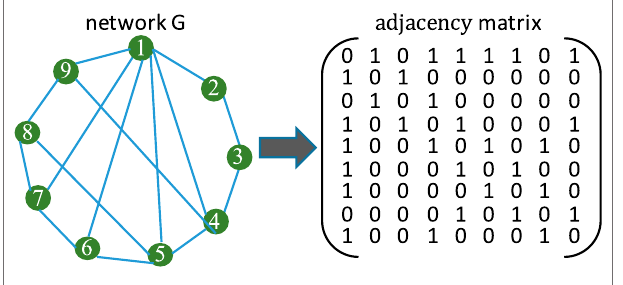
FIGURE 2 | An example of a simple network rewire